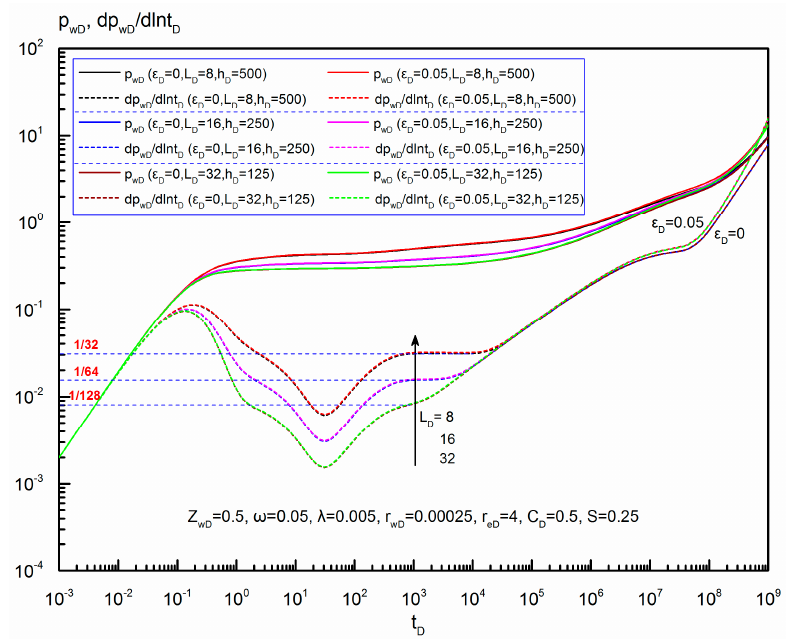
L ) on horizontal well’s transient pressure